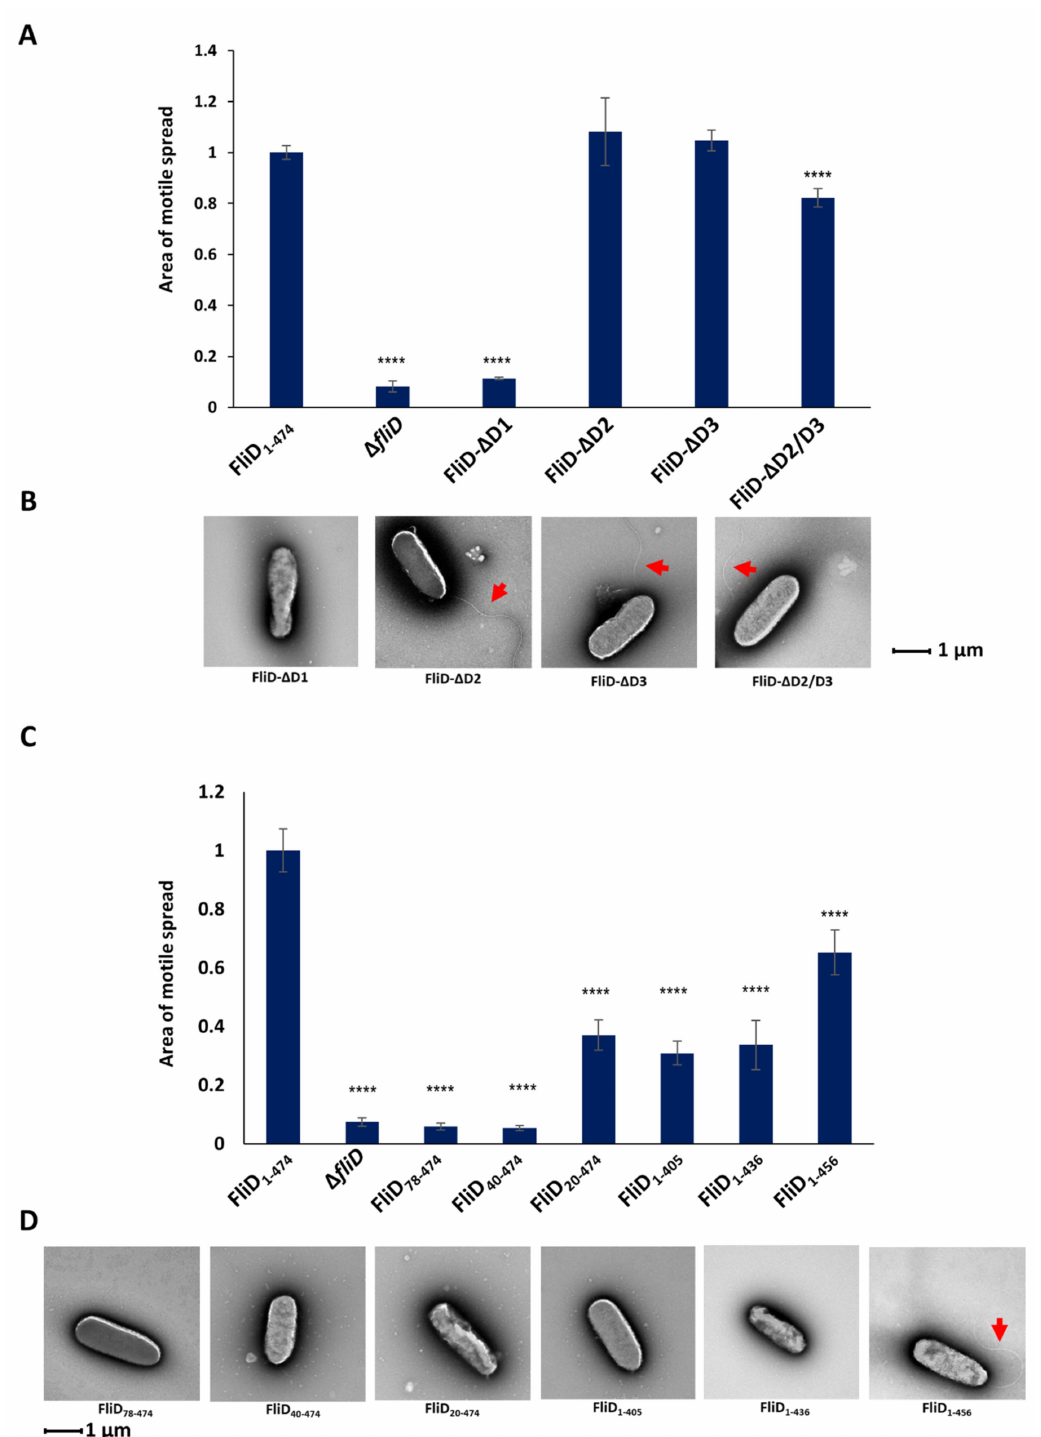
Figure 4. Effects of FliD truncations in flagellar formation and function. Swimming motility analysis and negative- stain EM images of knockout and complemented P. aeruginosa PAO1 strains of domain deletions ( A , B ) and domain D1 truncations ( C , D ). Area of motile spread for each strain is normalized to that of the full-length wild type complemented strain [ Pa ∆ fliD / fliD Pa (1-474)]. (**** p <